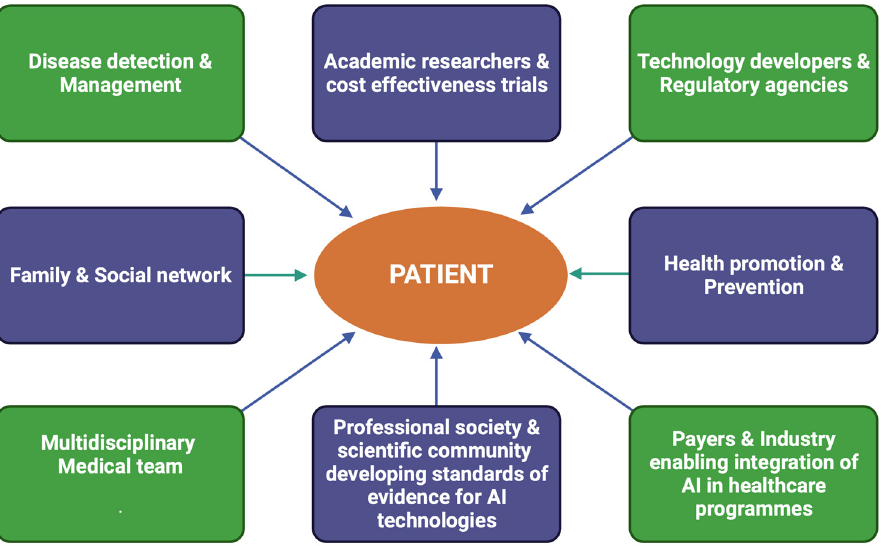
Figure 4. Stakeholders in the development of Al enabling personalized treatment in healthcare (modified from Mc Connell et al. & Sharma et al. [60,63]).